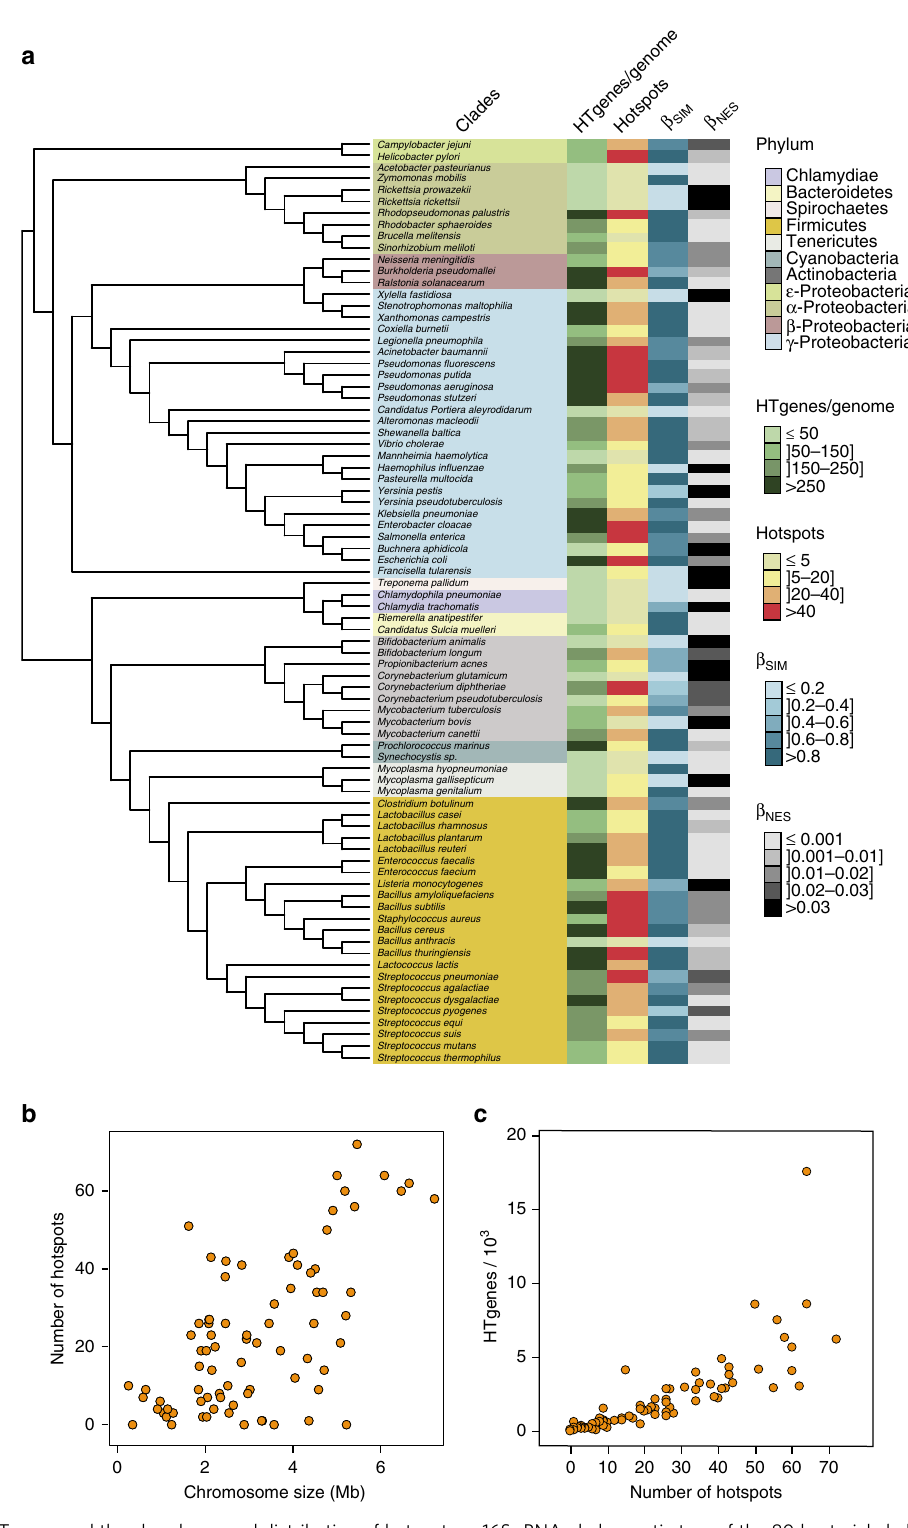
Fig. 3 Analysis of HTgenes and the abundance and distribution of hotspots. a 16S rRNA phylogenetic tree of the 80 bacterial clades. The tree was drawn using the iTOL server (itol.embl.de/index.shtml) 70 . The fi rst column indicates the clade and is colored by phylum. The four subsequent columns correspond respectively to: the average number of HTgenes per genome computed using Count, the number of hotspots, the average Simpson dissimilarity index ( β SIM , accounting for turnover), and the average multiple-site dissimilarity index accounting only for nestedness ( β NES ). These values are given in Supplementary Data set 1. b Distribution of the average number of hotspots per clade according to the average genome size ( G S ). c Association between the number of hotspots and the number of HTgenes in the